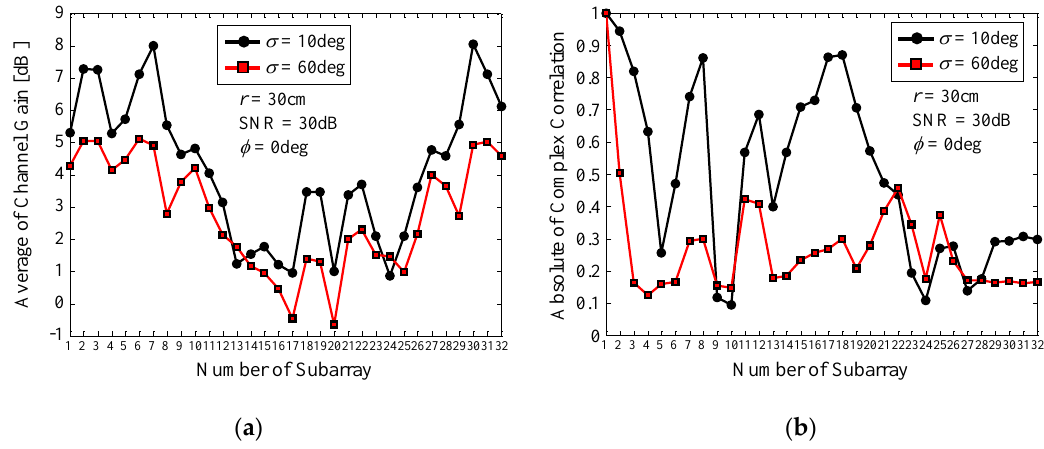
Figure 16. Channel gain and correlation characteristics of each subarray. ( a ) Channel gain. ( b ) Correlation.